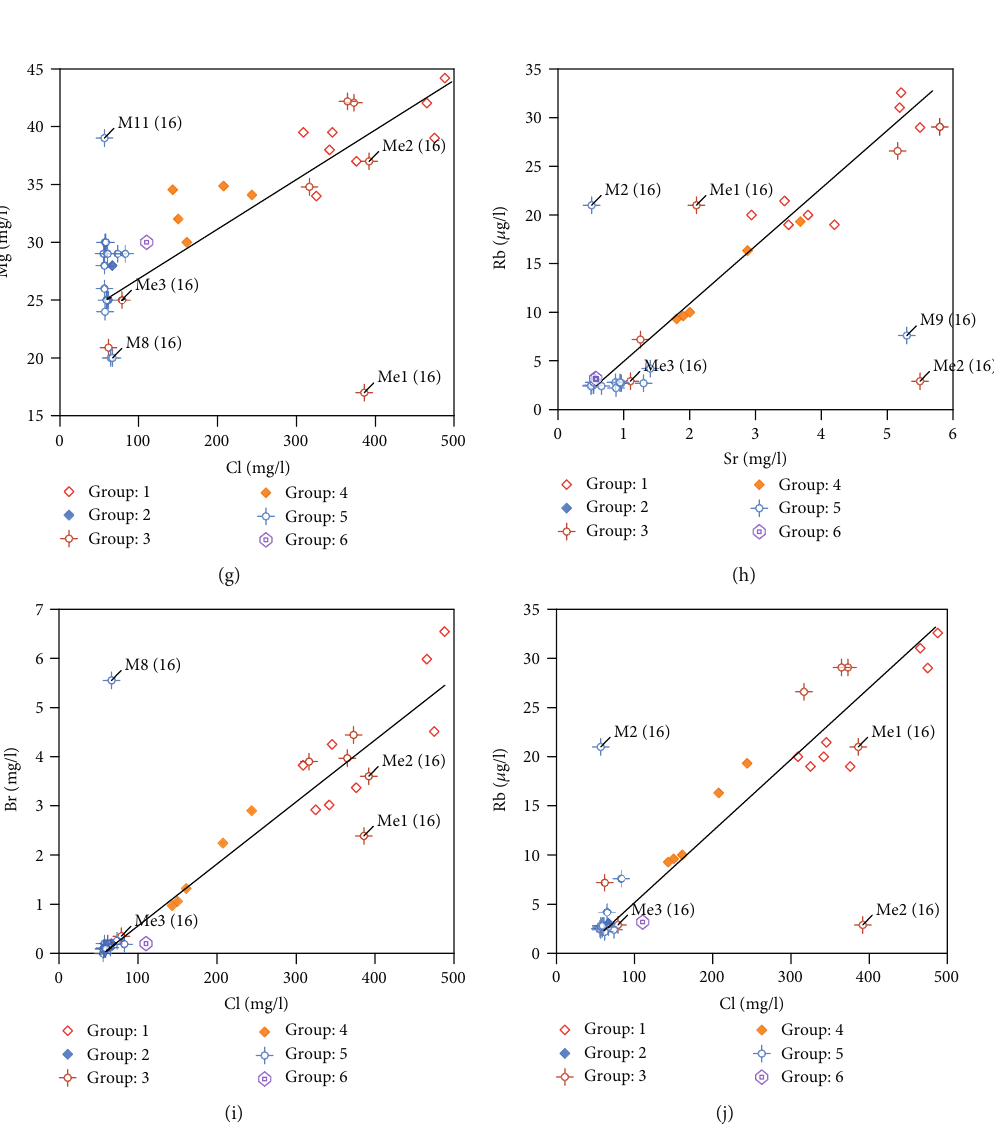
Figure 4: Crossplots of elements in the groundwater in the Lower Yarmouk Gorge. For details, refer to